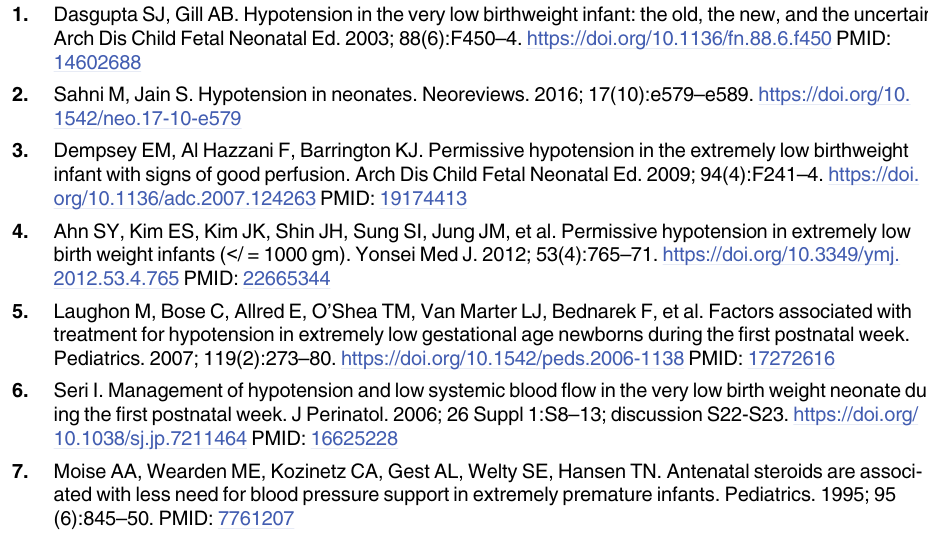
S1 Table. Demographic characteristics of populations (22–24 weeks). S2 Table. Risk factors of treated hypotension in VLBW infants during the first postnatal week (22–24 weeks). S3 Table. Multivariate logistic regression model for risk factors (22–24 weeks). S4 Table. The morbidity of treated hypotension in VLBW infants during the first postnatal week (22–24